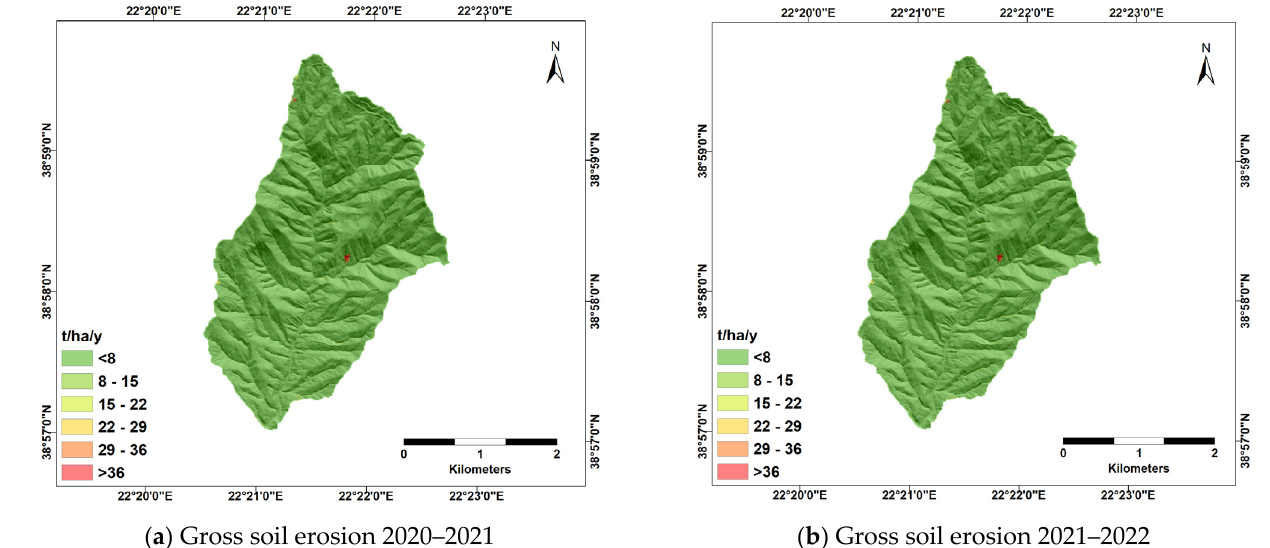
Figure 12. RUSLE erosion rates (t ha − 1 ) ( a ) from September 2020 to August 2021, ( b ) from October 2021 to September